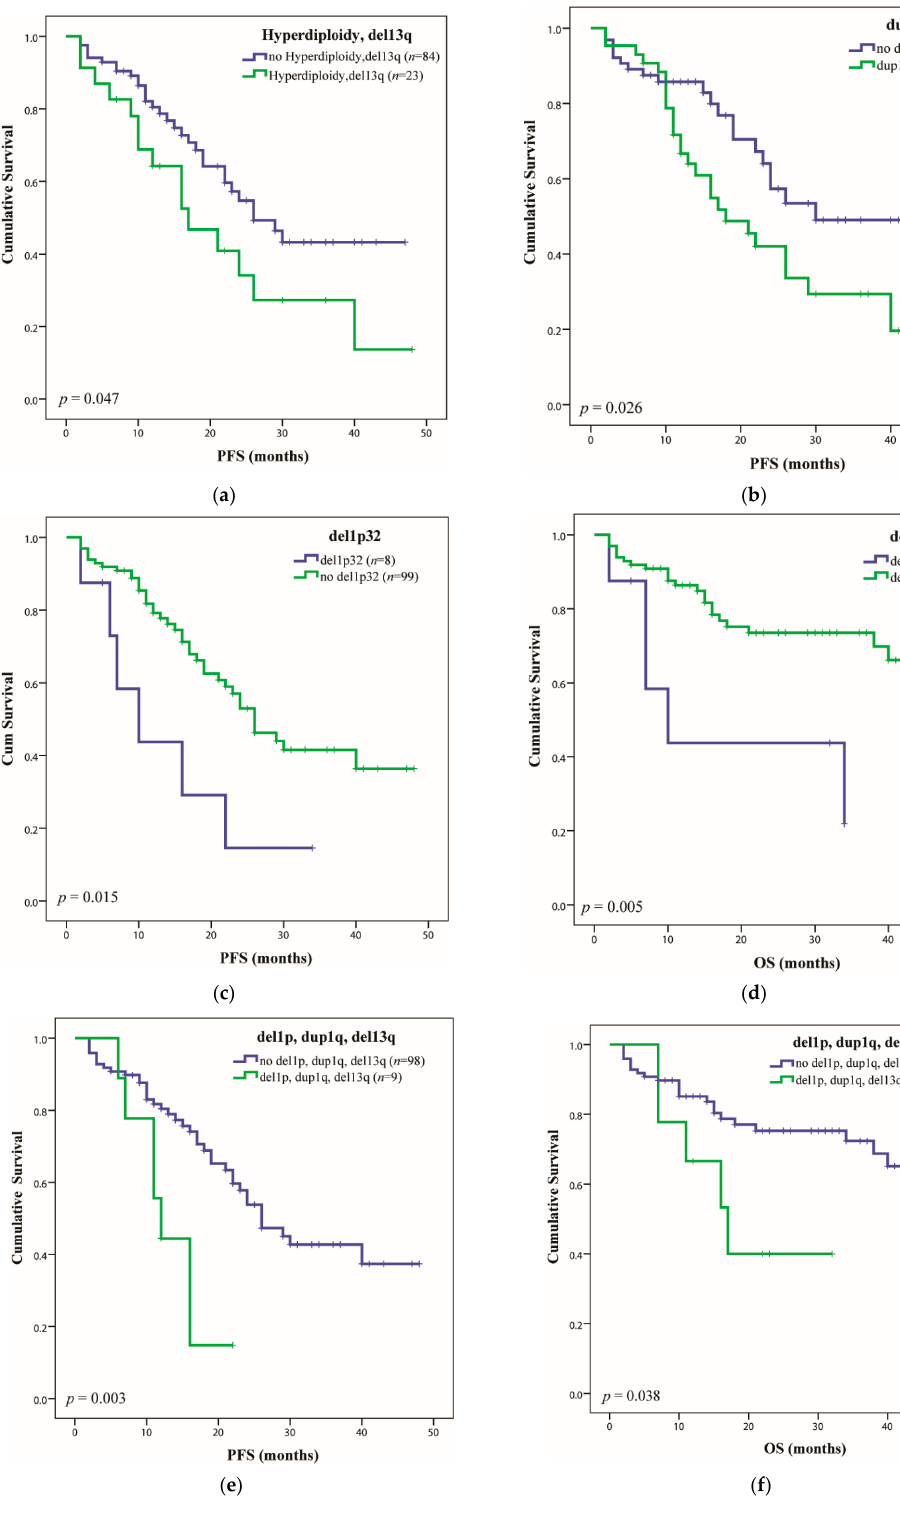
Figure 1. Overall survival (OS) and progression-free survival (PFS) of multiple myeloma (MM) pa- tients correlated with the identified CNAs. The Kaplan–Meier estimates of ( a ) PFS with the presence or absence of HRD with del13q; ( b ) PFS for dup1q positive group; ( c ) PFS and ( d ) OS of the group of patients that presented del1p32; ( e ) PFS for del1pdup1qdel13q positive group; ( f ) OS for del1pdup1qdel13q positive group.